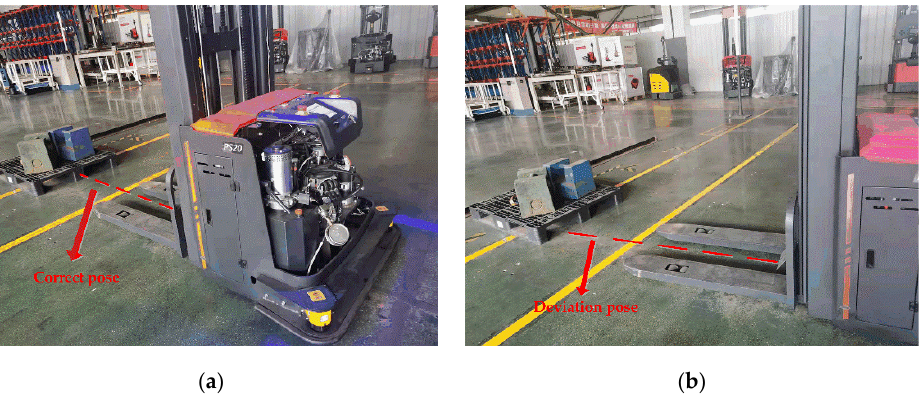
Figure 1. Diagram of pallet position deviation. ( a ) Correct pose. ( b ) Deviation pose.